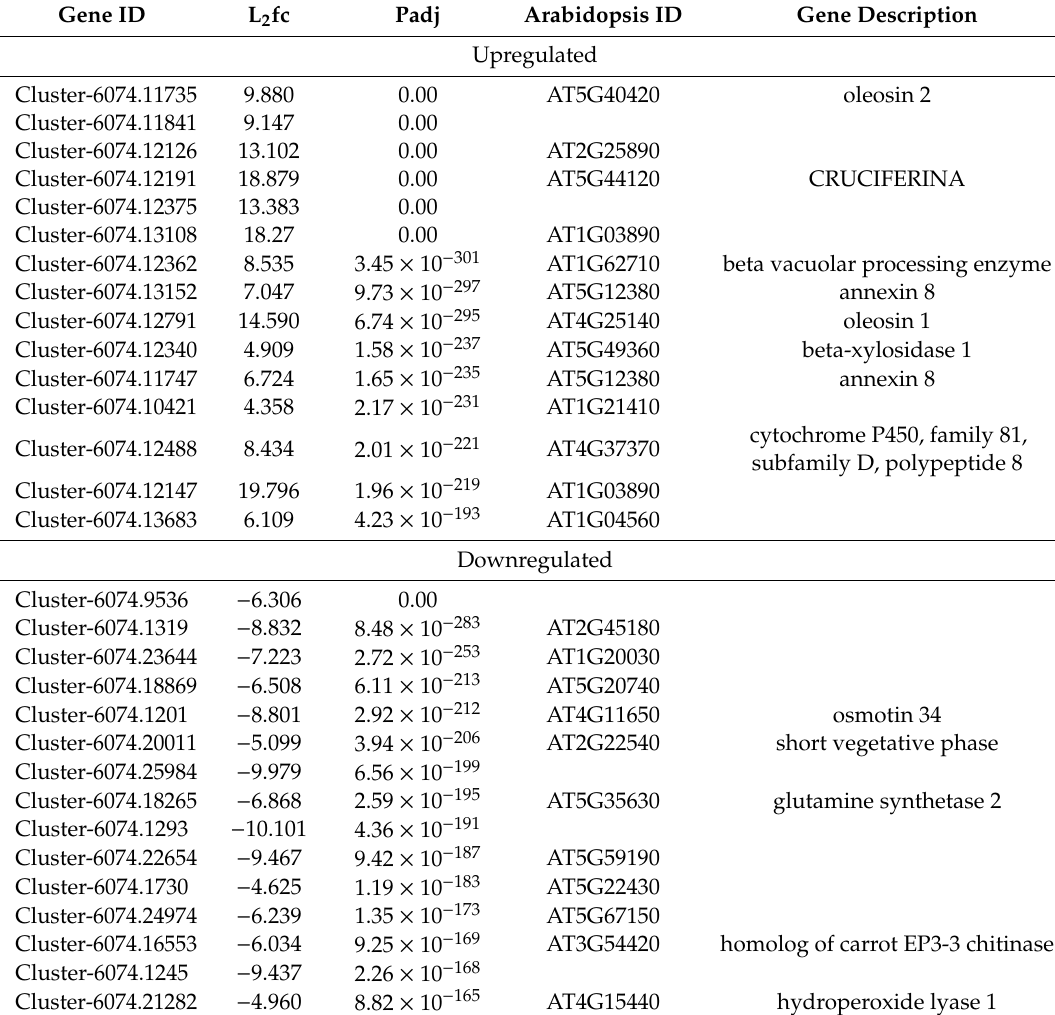
Table 2. The top 30 up- and downregulated